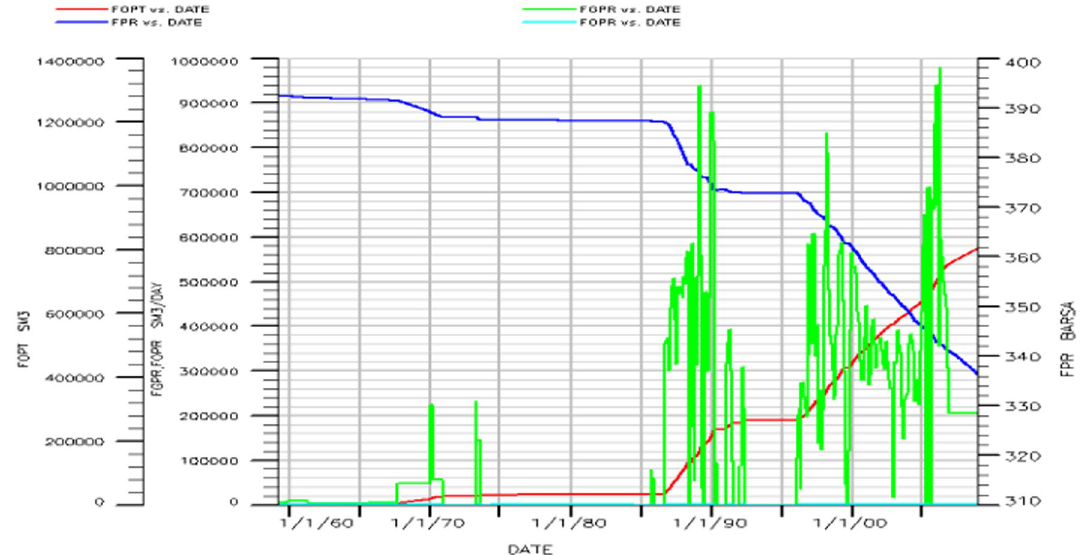
Fig. 4 Field gas production rate, field oil production rate and field pressure rate under history